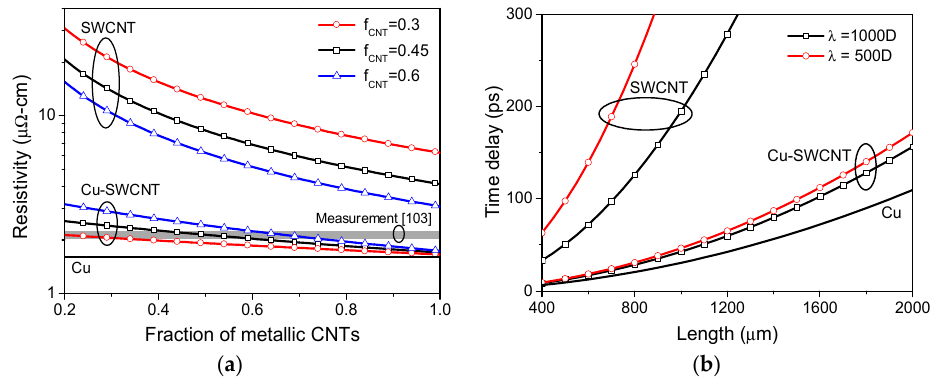
Figure 19. ( a ) Effective resistivity and ( b ) time delay of Cu, SWCNT, and Cu-SWCNT composite Figure 19. ( a ) E ff ective resistivity and ( b ) time delay of Cu, SWCNT, and Cu-SWCNT composite interconnect [ 114 ] . interconnect